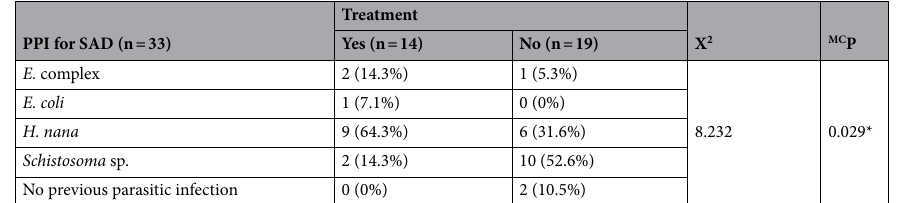
Table 2. Previous parasitic infection and its association with anti-parasitic treatment in Blastocystis- positive subjects in West Ismailia, Egypt. PPI: Previous parasitic infections within the last year; SAD: Subjects with available data; E. complex: Entamoeba histolytica / dispar / moshkovskii ; E. coli : Entamoeba coli ; H. nana : Hymenolepis nana ; sp.: Species; * χ 2 Chi-squared test, MC: Monte Carlo P : p value for comparing between the studied groups, *statistically significant at p ≤ 0.05.